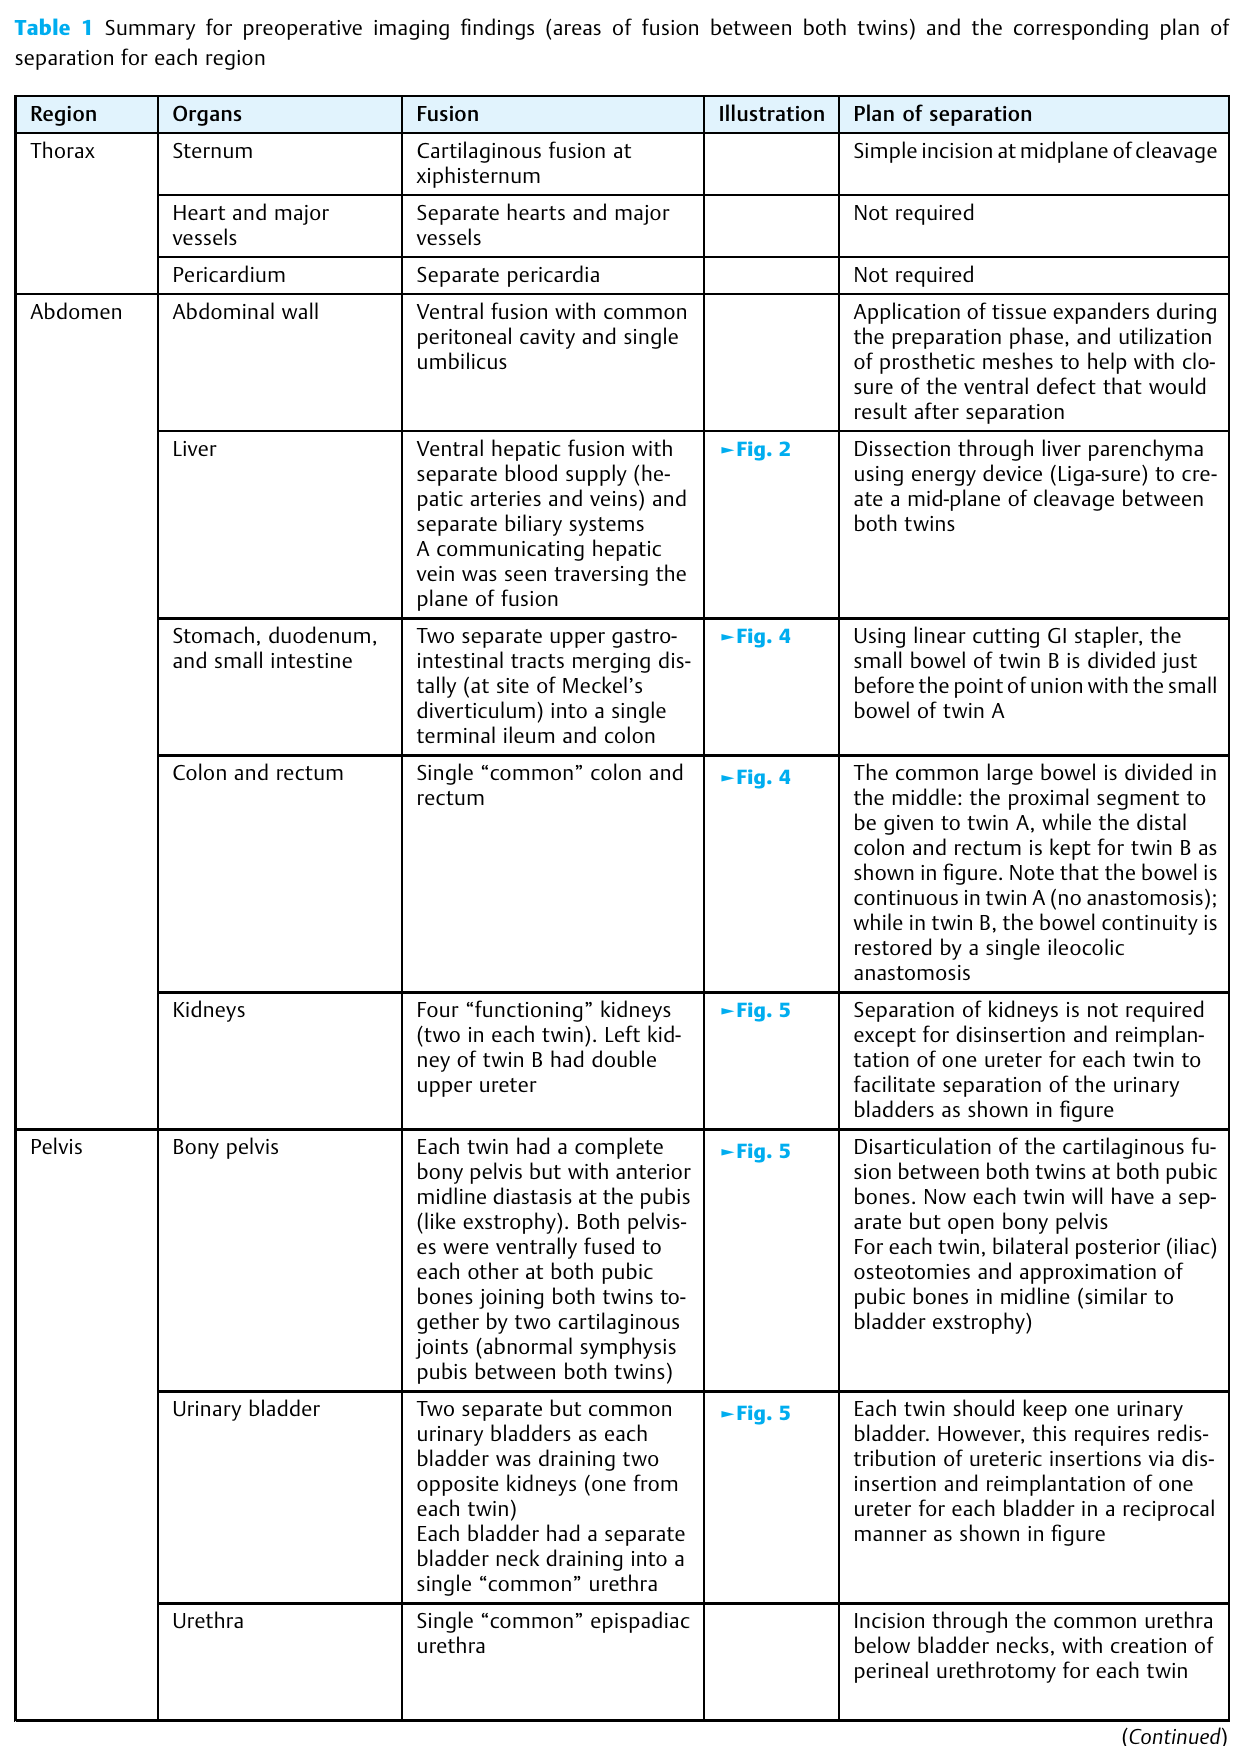
Incision through the common urethra below bladder necks, with creation of perineal urethrotomy for each twin ( Continued